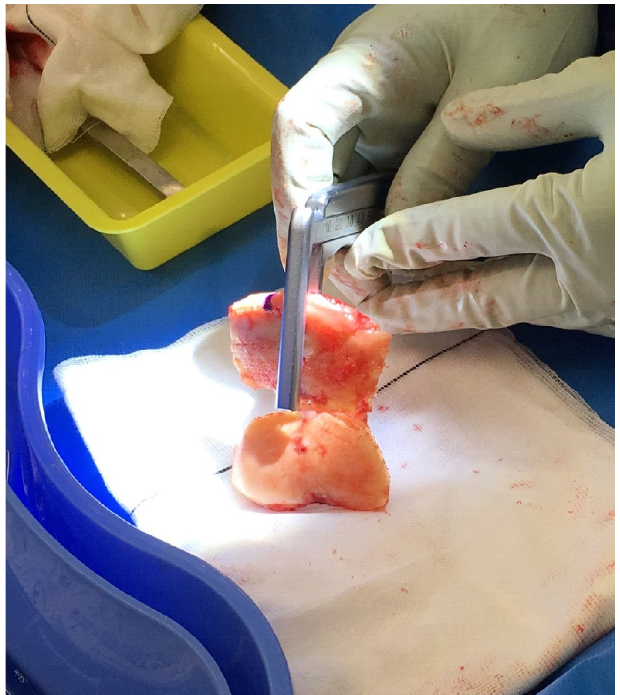
Figure 3. Measurement of the medial and lateral distal femoral condyle and posterior condylar cuts. Sequential pinning of the block was carried out very carefully with 2 distal pins (through the 3D block) followed by 2 anterior femoral pins (through the in situ jig). The oblique anterior femoral pin was placed last to prevent any movement of the 3D block whilst resecting. Distal femoral resections were then done through the in situ jig. The posterior condylar cuts were done through the appropriate standard 4:1 in block as per plan. The largest thickness of bony prominence was recorded by the senior surgeon using Vernier Calipers for each resected medial and lateral distal femoral condyle. Three separate measurements (cid:3) horizontal, vertical and diagonal were made, and the average measurement was recorded independently.